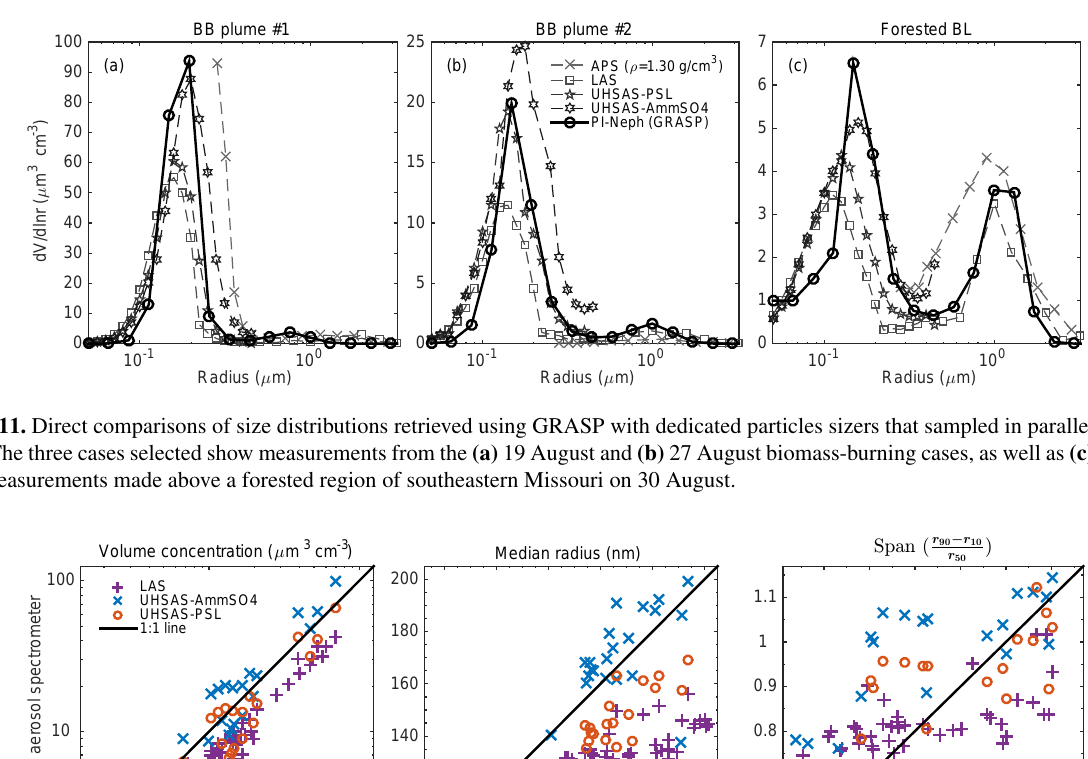
− r 10 . The value retrieved from r 50